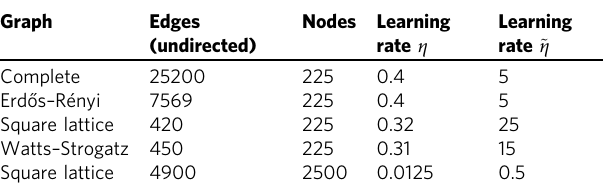
Table 1 Learning rates η (AI Pontryagin) and ~ η (AGM) used to control Kuramoto dynamics on different graphs. All ANNs use stochastic gradient descent for learning and only differ in their learning rate. The number of hidden layers and hidden layer neurons are 1 and 2, respectively. We use ELU activation functions and train the ANN for two epochs. At each node, we include a bias term and set all weights initially to a value of 10 − 3